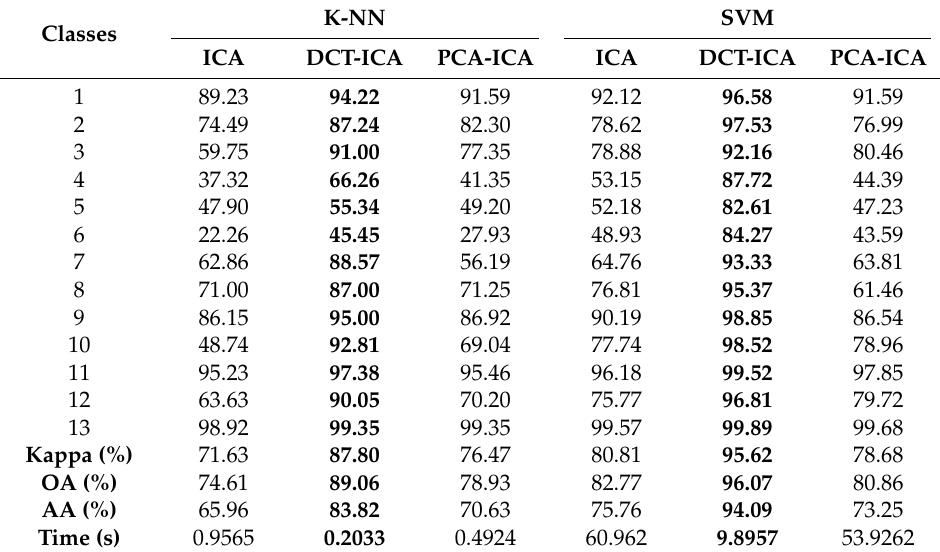
Table 5. Classification accuracy using K-NN and SVM classifiers on the KSC Dataset.